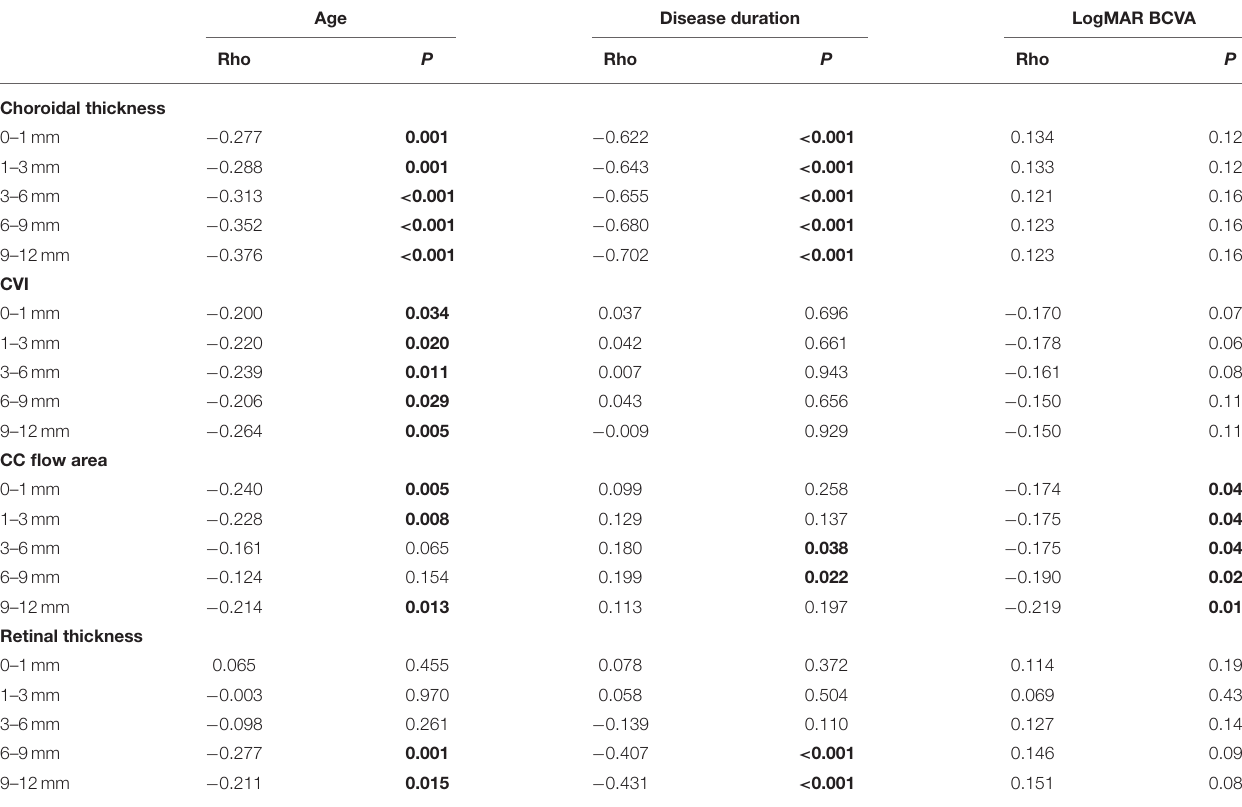
TABLE 3 | Correlation analyses between clinical parameters and OCTA quantitative measurements in 69 patients with VKH disease. Age Disease duration LogMAR BCVA Rho P Rho P Rho